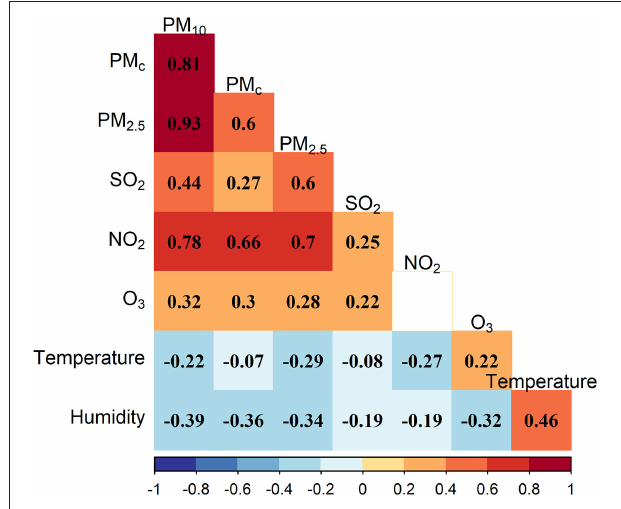
FIGURE 2 | Correlation plot of the air pollutants and meteorological